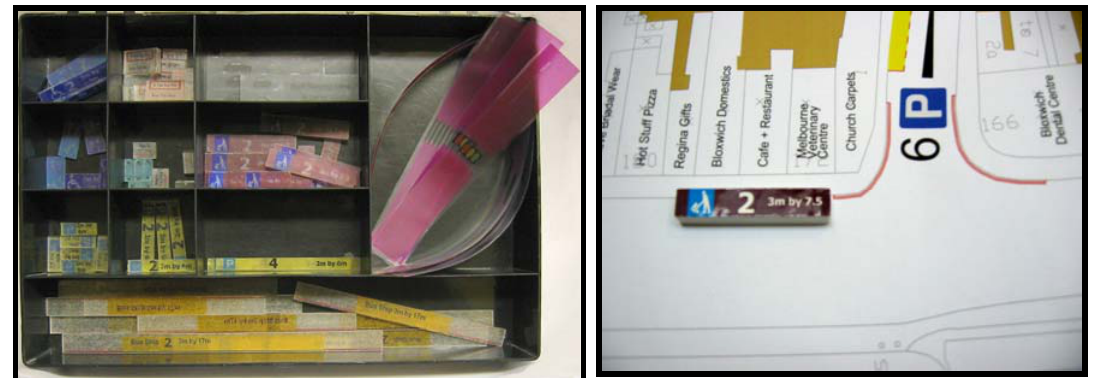
Figure 11. Use of blocks and acetates to redesign space use on a high street Source: Jones and Thoreau (2007), Figure